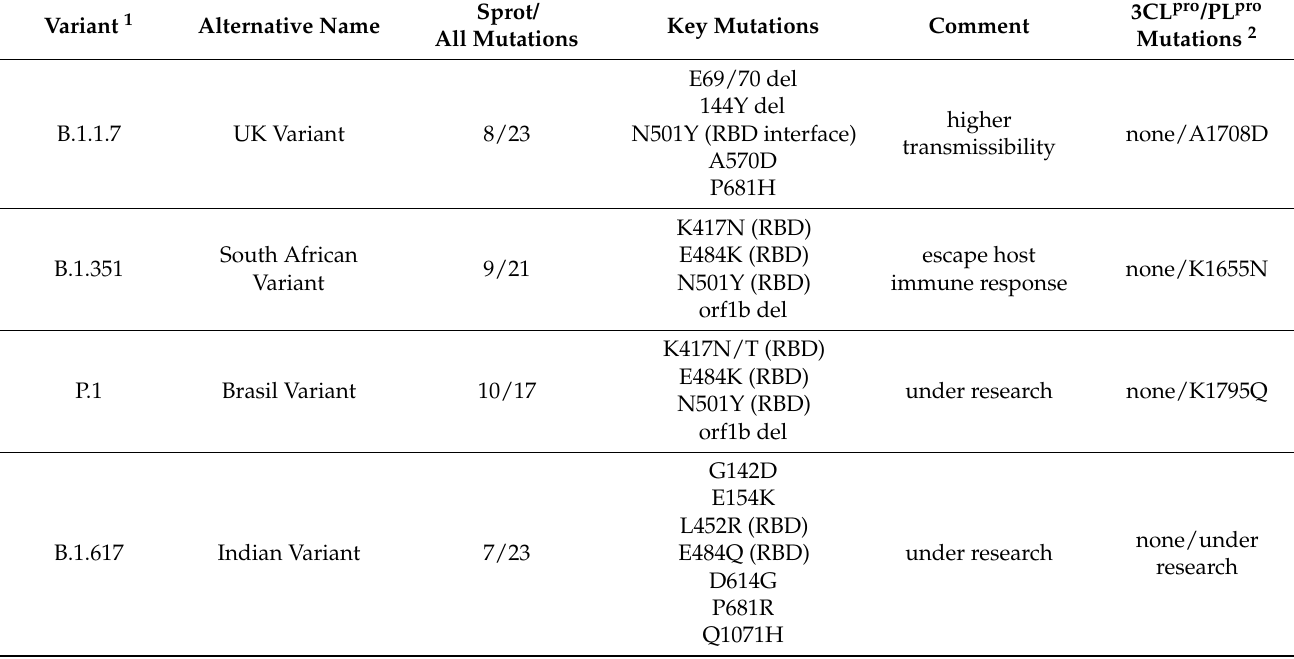
Table 1. Summary of dominant SARS-CoV-2 variants and relevant